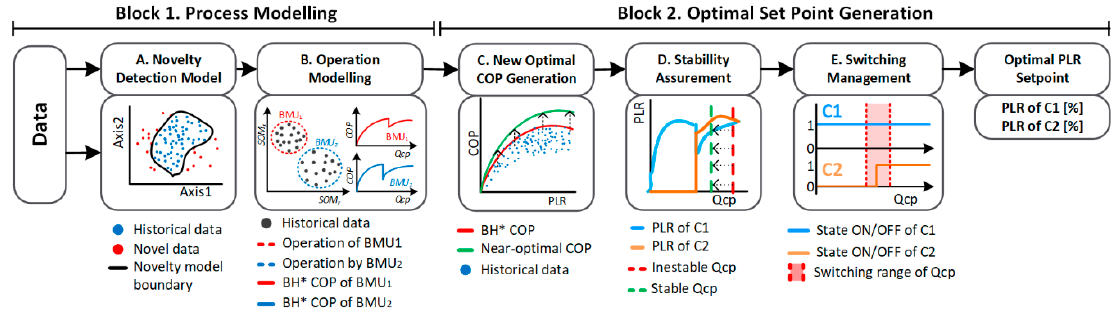
Figure 4. Proposed methodology diagram. Note that the diagram illustrates the example case in which two compressors, C1 and C2, are used to supply the cooling demand. * BH stands for best historical.